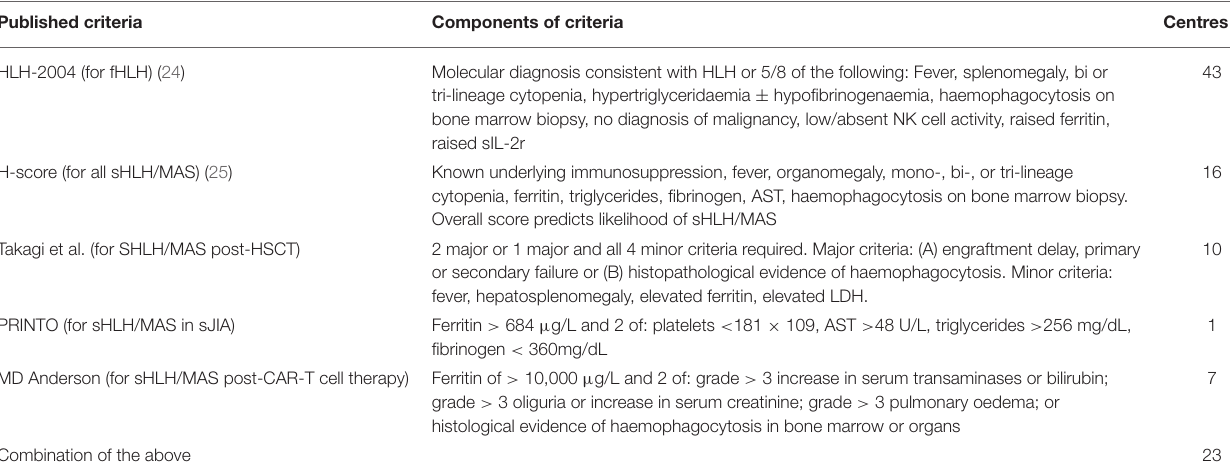
TABLE 1 | Use of published criteria to support the diagnosis of sHLH/MAS post-HSCT or CAR-T cell therapy. Published